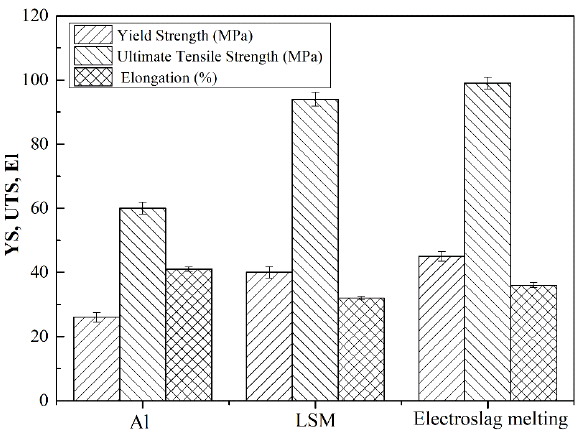
Figure 12: Mechanical properties of 5 wt.% TiB 2 /Al composites prepared by different processes.